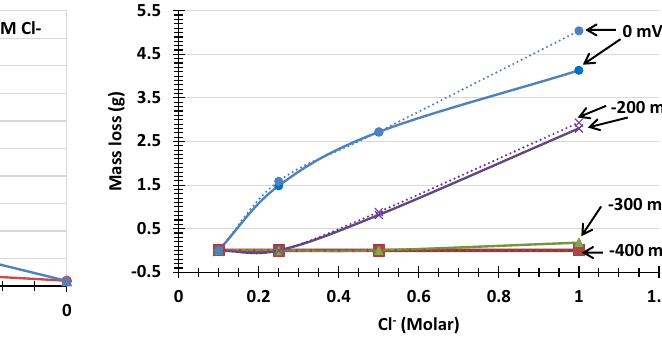
Figure 10: Relationship of passive period vs AP for HSHCsw in dea - erated electrolyte at pH 13.4 at 0.5 and 1 M Cl − .